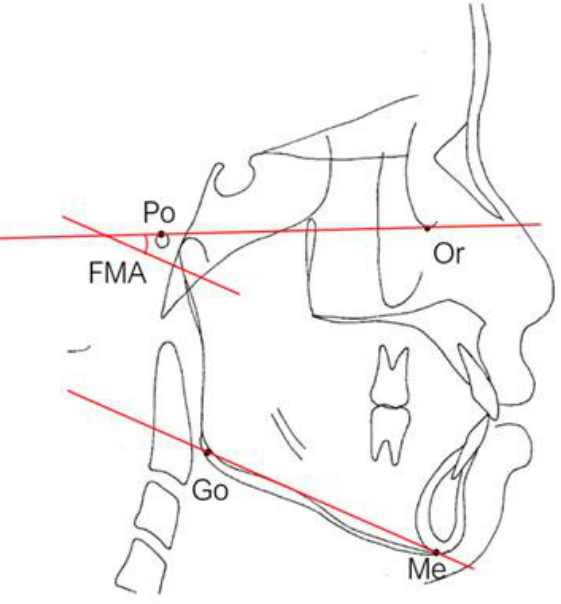
Figure 5. The Frankfort–mandibular plane angle (FMA). The FMA is formed by the intersection of the Frankfort horizontal plane and the mandibular plane.